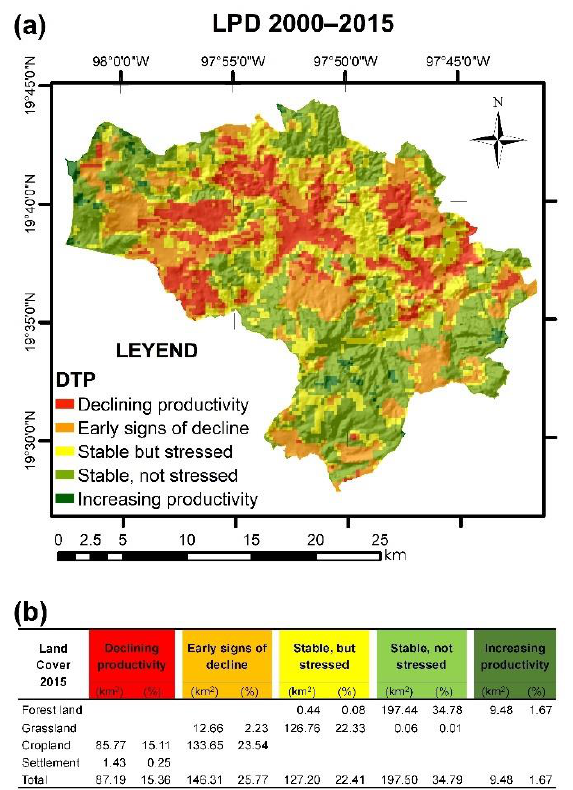
Figure 4. ( a ) Spatial distribution of Land Productivity Dynamics (LPD) between 2000 and 2015 in Ixtacamaxtitlan, Puebla, México; ( b ) Distribution (area and %) of Land Productivity Dynamics (LPD) classes between 2000 and 2015.